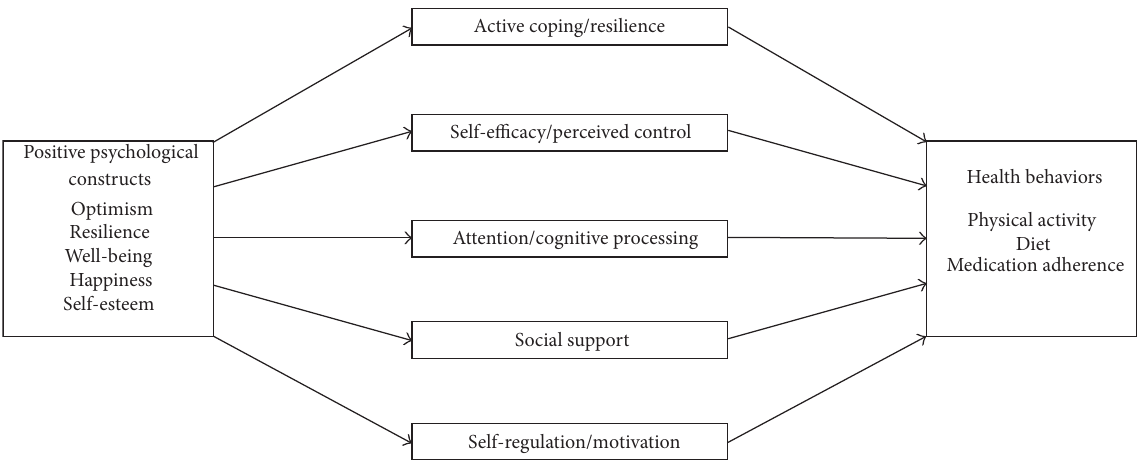
Figure 1: Conceptual model outlining the proposed mediators between positive affect and improved health behaviors. Note . This model displays relationships in one direction, though there are bidirectional relationships between most constructs (e.g., being more physically active leads to positive